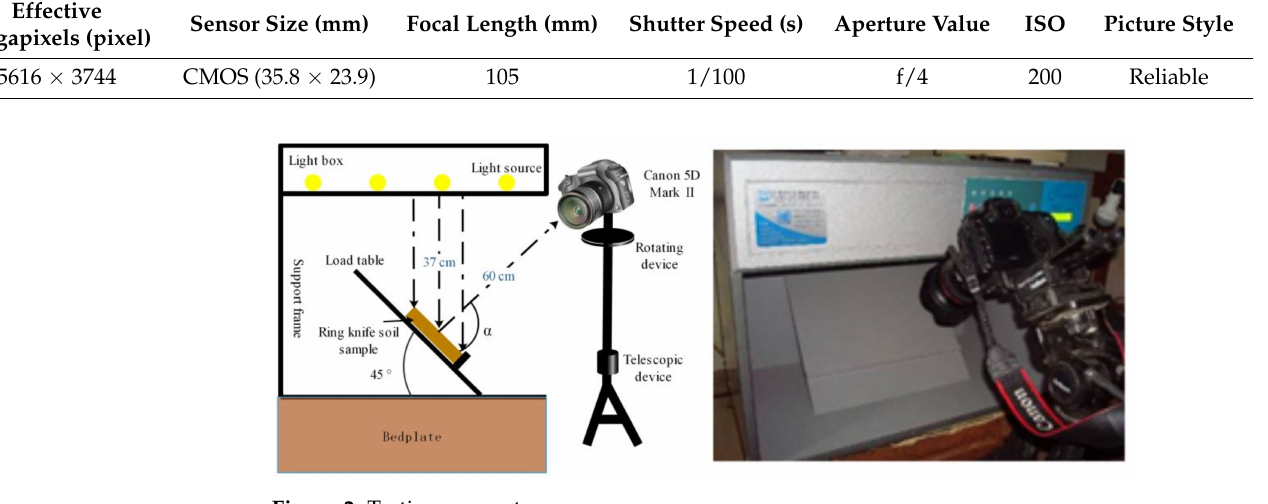
Figure 2. Testing